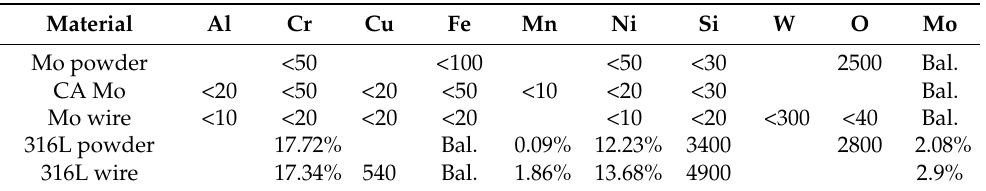
Table 1. Composition of commercially available material used (as specified by the manufacturer). If not otherwise indicated, values are given as